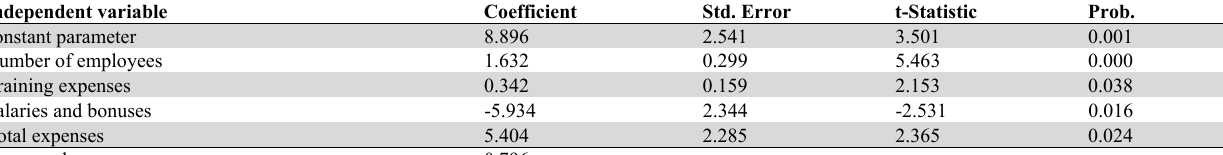
The effect of the four independent variables on the dependent variable net profit after tax Independent variable Coefficient Std.